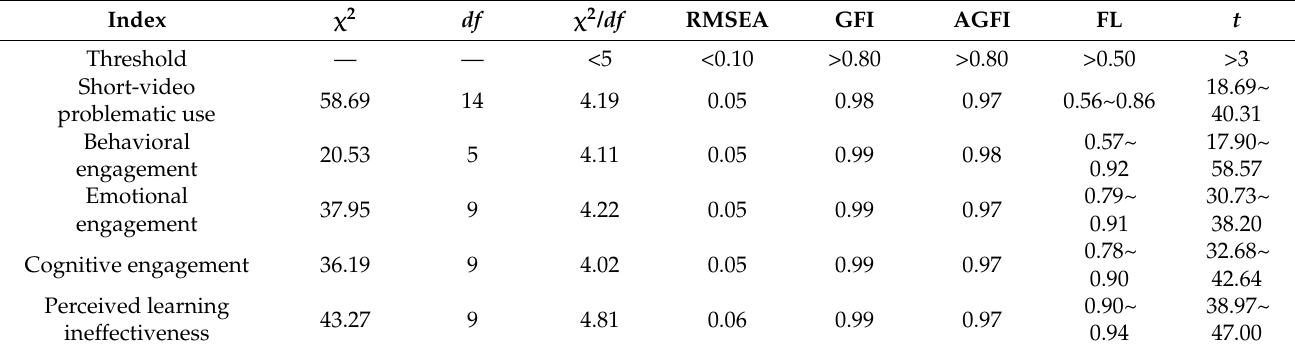
Table 1. Confirmatory factor